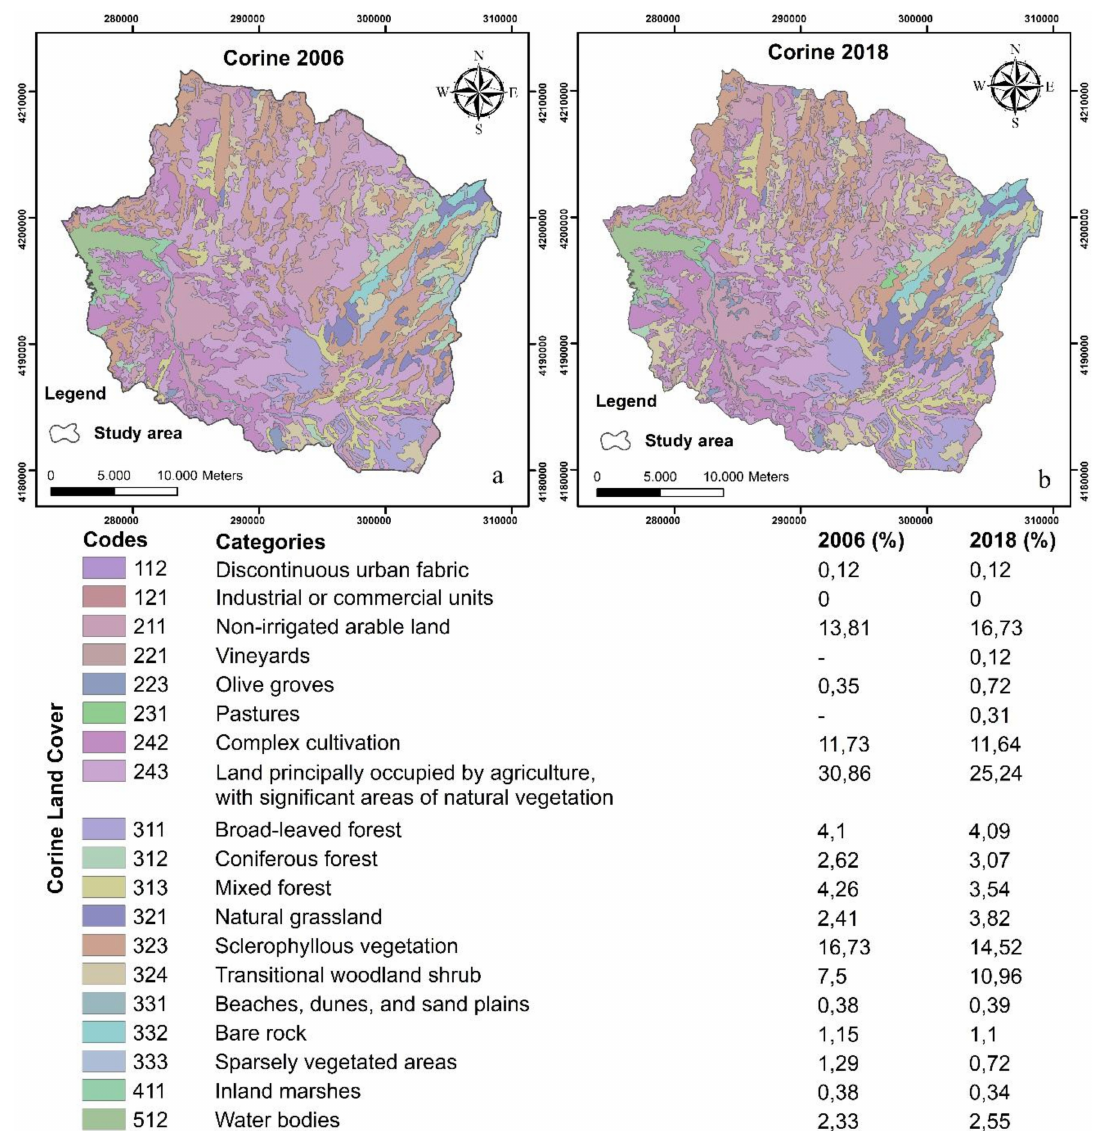
Figure 6. ( a ) Corine Land Cover 2006 map and ( b ) Corine Land Cover 2018 map of the pilot